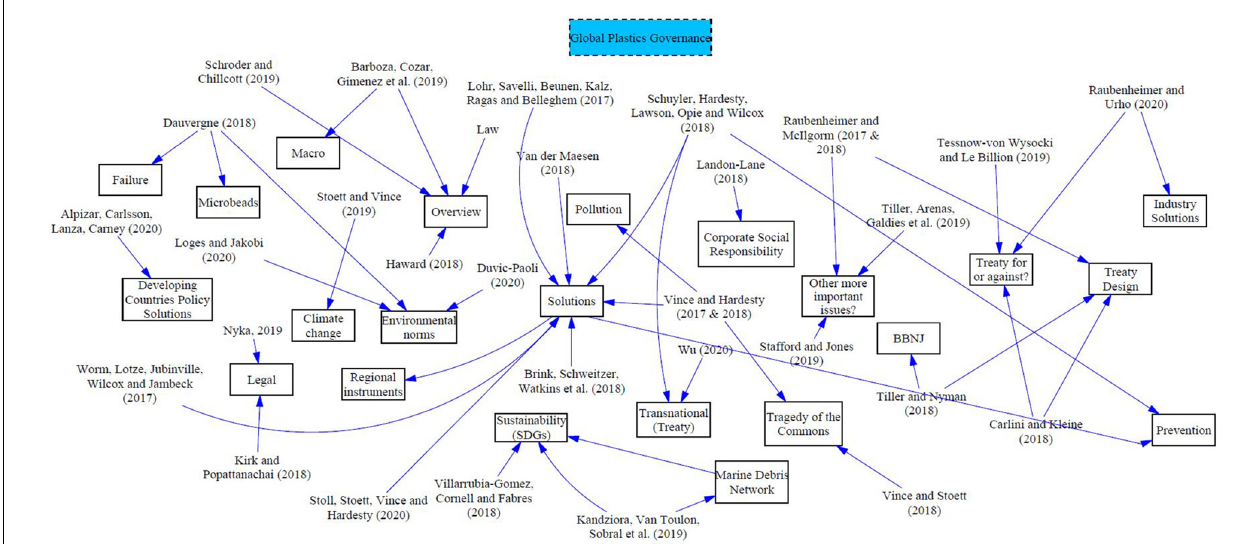
FIGURE 1 | Mind Map of key authors and topics covered.